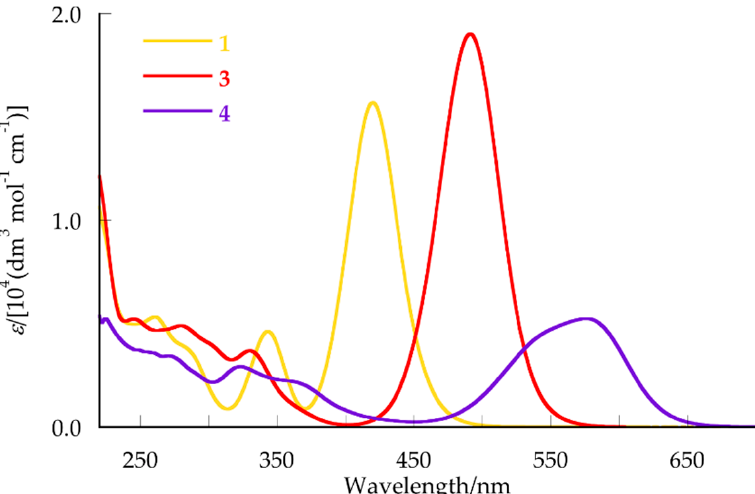
Figure 3. UV-vis spectra of disilenes 3 (reddish-orange), 4 (purple), and 1 (yellow) in hexane at room temperature.